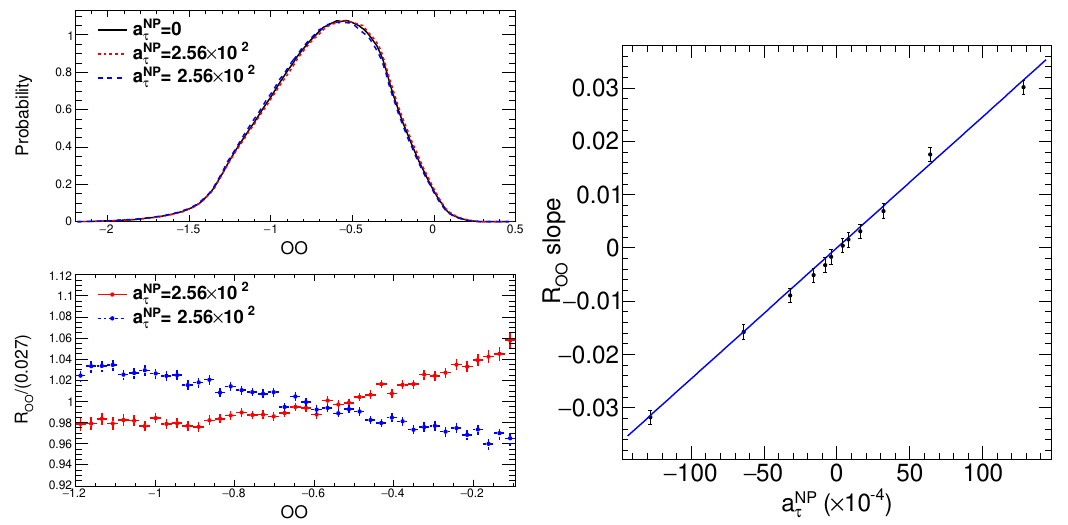
Figure 8 . The probability distributions of OO (top) and R OO as a function of OO for di(cid:11)erent a NP ’s (left), and the R OO slope as a function of a NP (cid:28) correspond to 50 fb (cid:0) 1 of data.